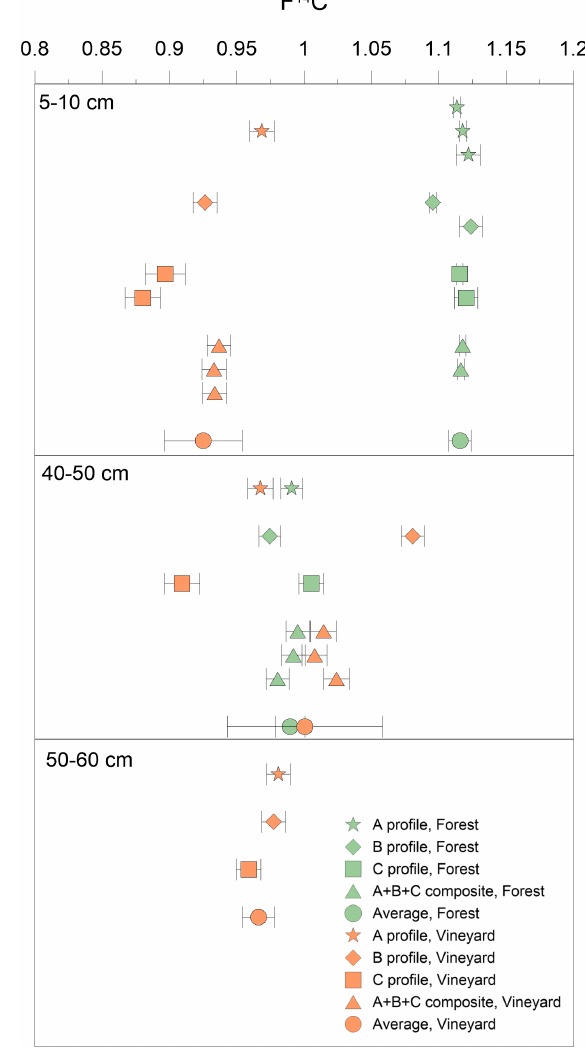
Figure 4. Comparison of intra-layer F 14 C heterogeneity at three depths (5–10, 40–50, and 50–60cm) in forest and vineyard soils. F 14 C data were obtained for profiles A (star), B (diamond), C (square), composites A + B + C (triangle), and the average of these data (round) in forest (green) and vineyard (orange) soils. Er- ror bars represent the analytical error for the profiles A, B, and C and the standard deviation for the mean.